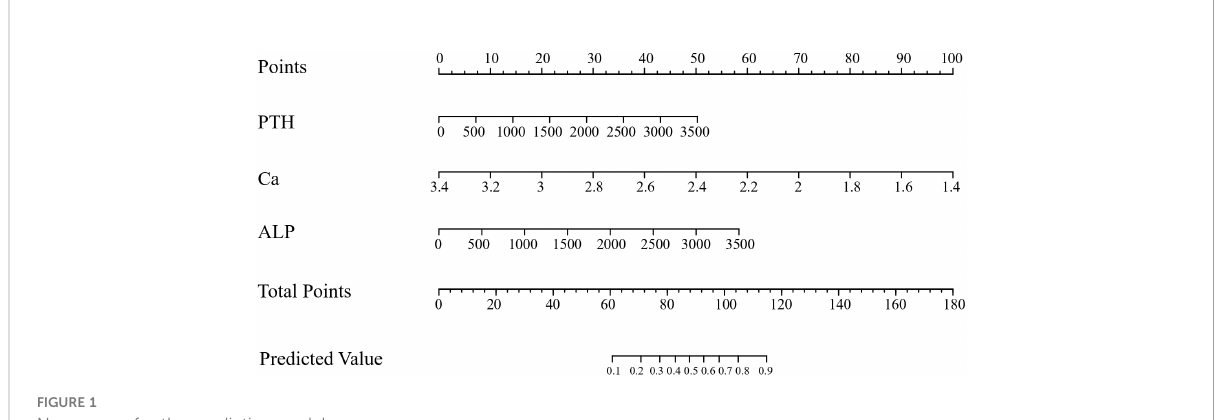
FIGURE 1 Nomogram for the predictive model.